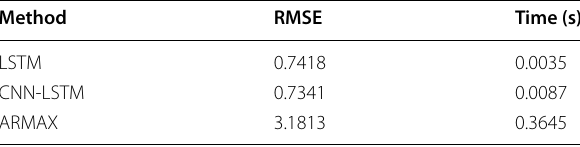
data sets of LFP signals recorded during different tasks.